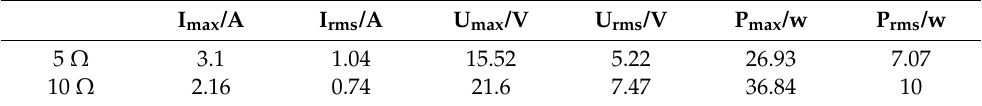
Figure 7. Load simulation results. Table 2. The result values of the